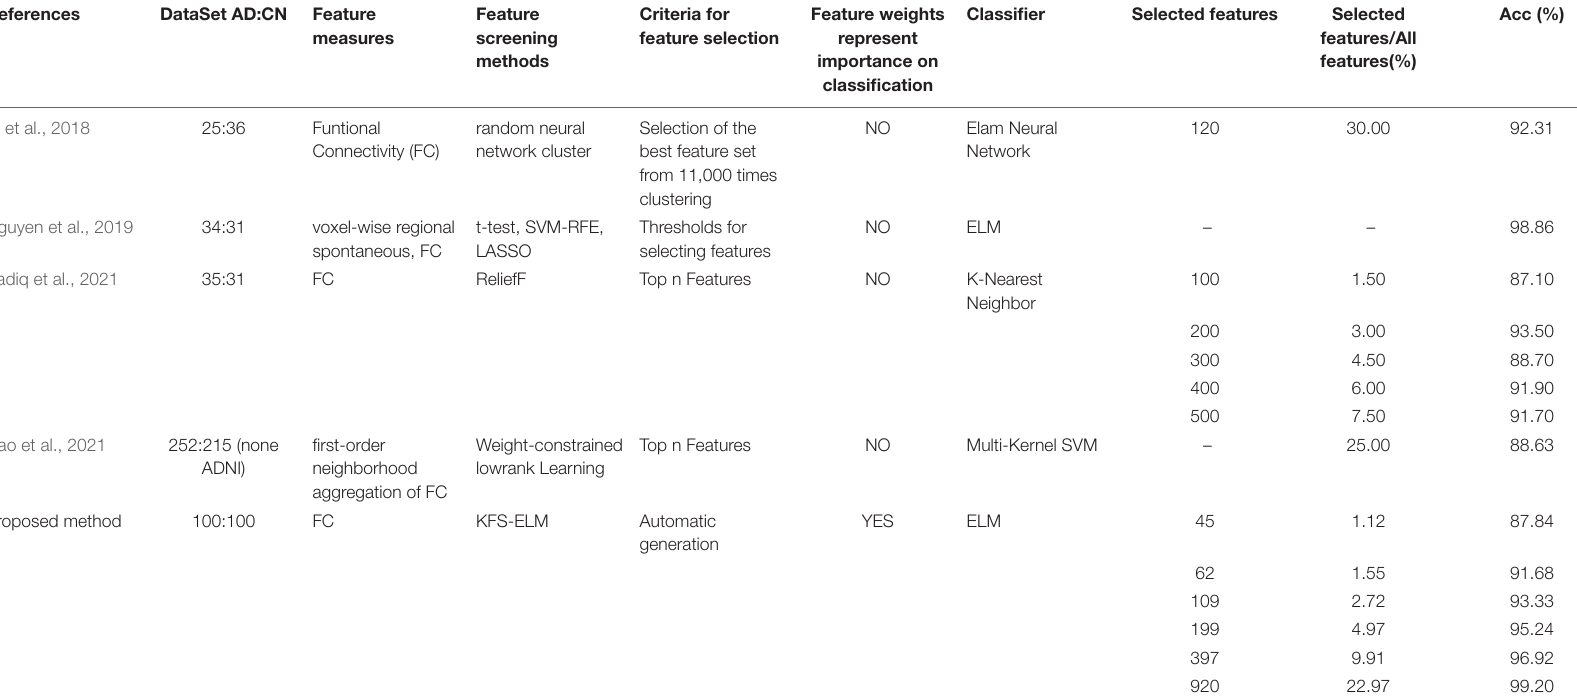
TABLE 7 | Comparison the performances with